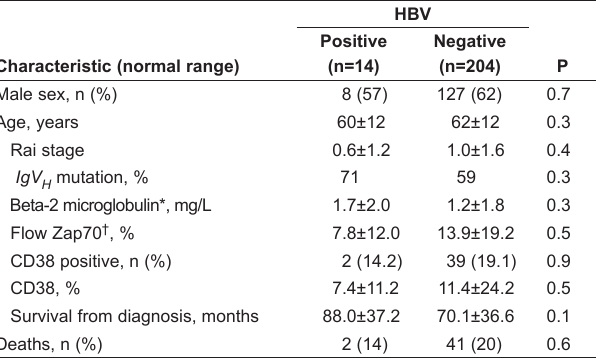
Table 3 Comparisons of hepatitis b virus (HbV)-positive and HbV- negative chronic lymphocytic leukemia patients